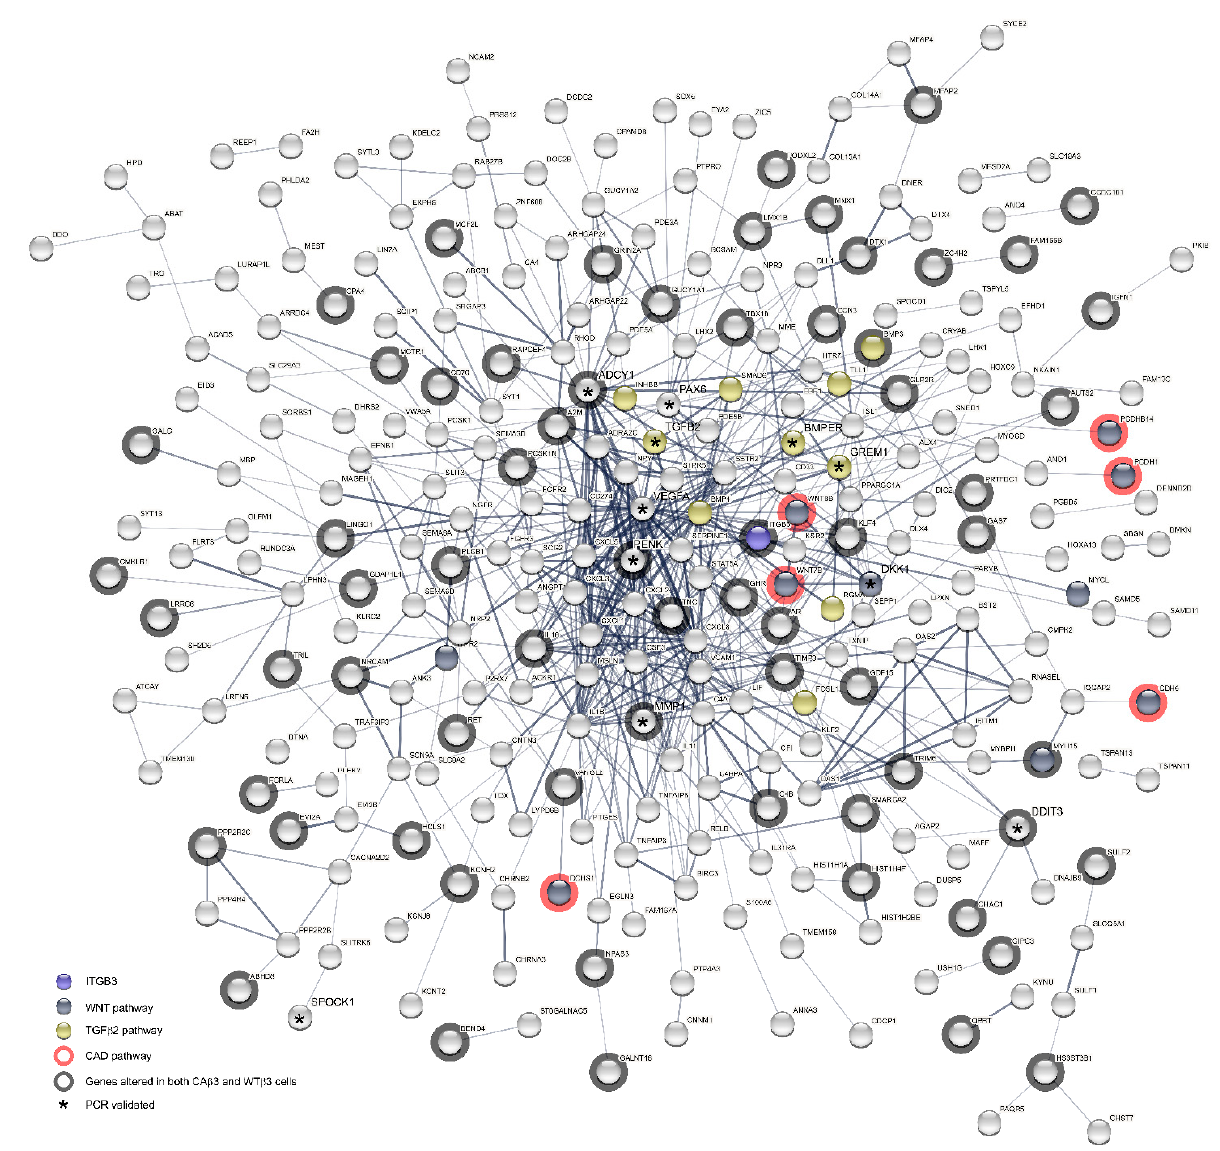
Figure 13. Medium confidence CA β 3 PPI network shows an extensive network of potential interactions. Differentially expressed genes resulting from overexpression of a CA- α v β 3 integrin were entered into the STRING database. The input consisted of uniquely altered genes as well as altered genes that were shared with cells overexpressing a WT- α v β 3 integrin. The calculated network (statistical confidence = 0.4) has a PPI enrichment value = 1 × 10 − 16 indicating that the network has significantly more interactions than expected for a random collection of input genes at the same confidence level. The location of β 3 integrin (INTB3), members of the TGF β 2, Wnt and Cadherin signaling pathways as well as those gene products that are also differentially expressed in CA β 3 cells are all indicated. * Genes that were validated by RT-qPCR. The proteins for which there were no connections to be mapped where not displayed. (Interactive link for Figure 13: permanent link: https://version-11-0b.string-db.org/cgi/network?networkId=bfy9gG5S77FU) (accessed on 20 June 2021).